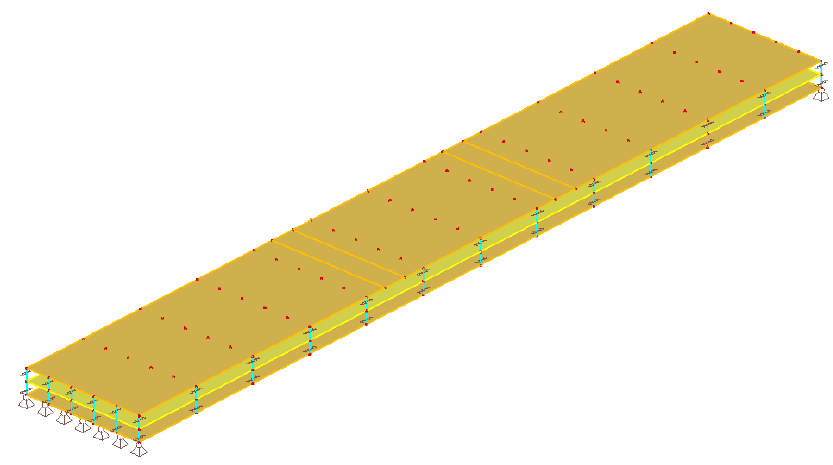
Figure 6. Numerical model of the CLT 140-3 in SCIA Engineer.